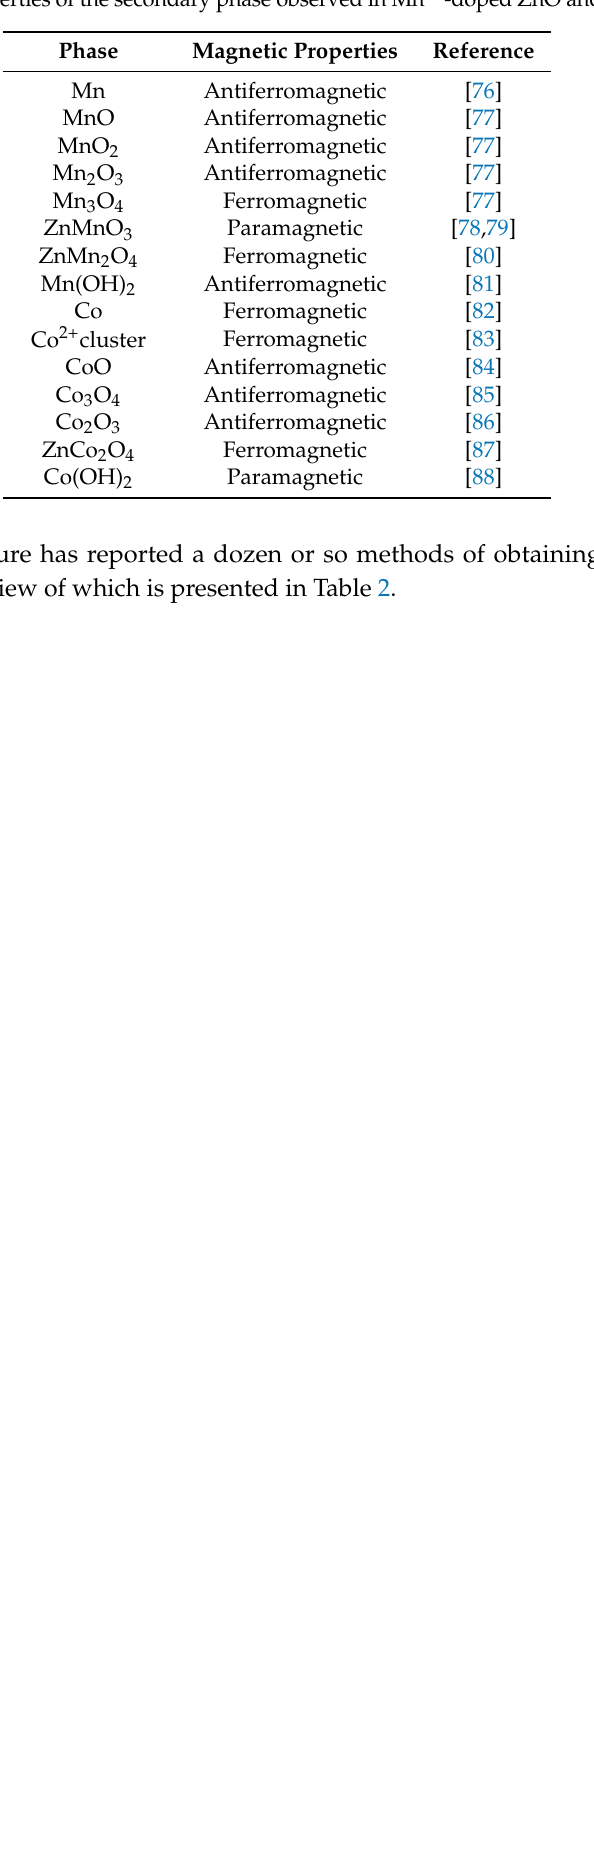
Table 1. Magnetic properties of the secondary phase observed in Mn 2+ -doped ZnO and Co 2+ -doped